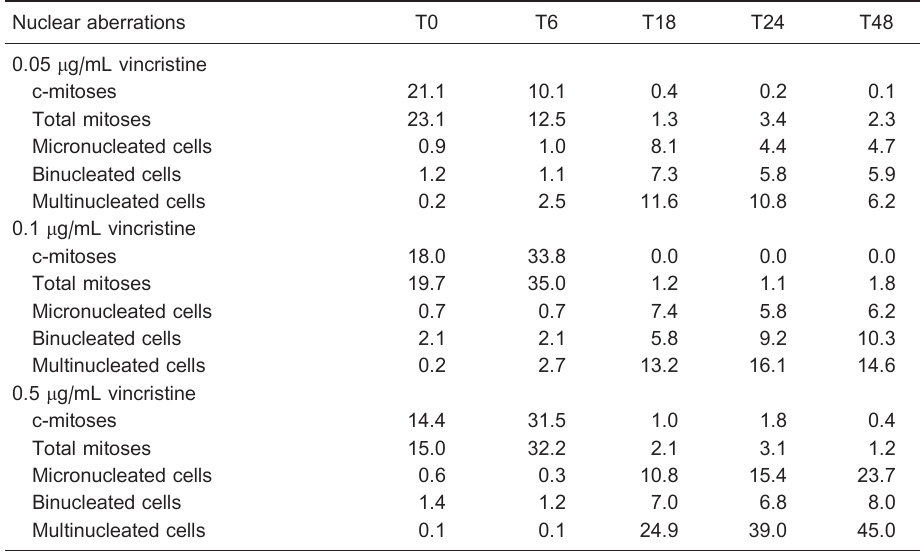
Table 1. Effects of double blockade (FCS deprivation ++ 0.05, 0.1 or 0.5 m g/mL vincristine) on A549